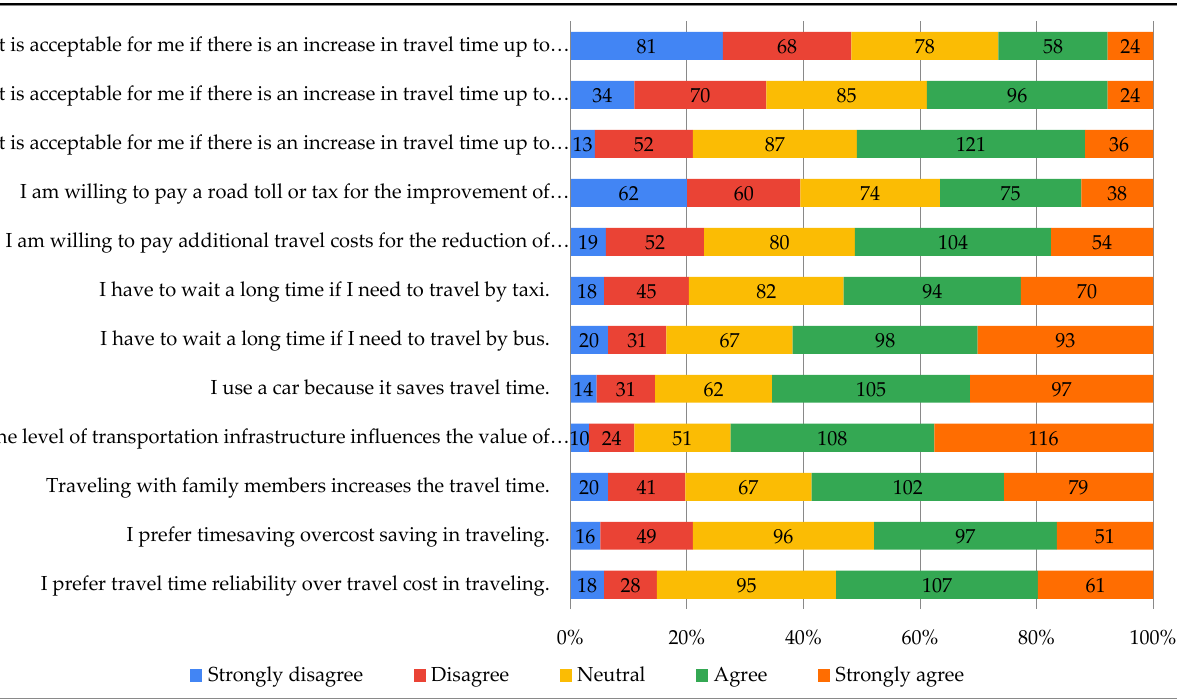
Figure 1. Distribution of respondents’ level of importance for travel time saving.